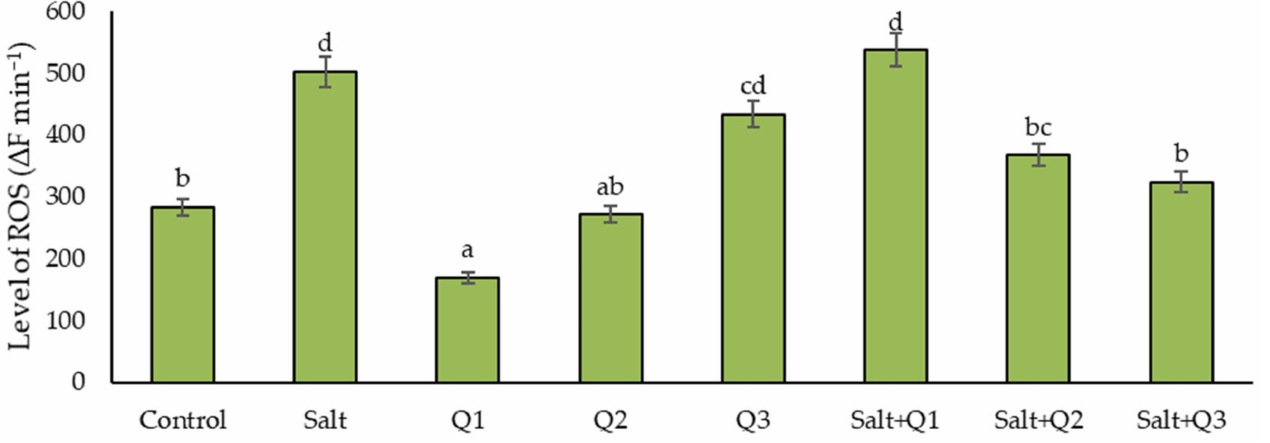
Figure 4. Effect of quercetin–copper complex (Q-Cu (II)) concentrations and salt stress on the level of reactive oxygen species (ROS). Different letters indicate significant differences between each variant of the experiment, according to ANOVA (followed by Tukey’s HSD test, p =